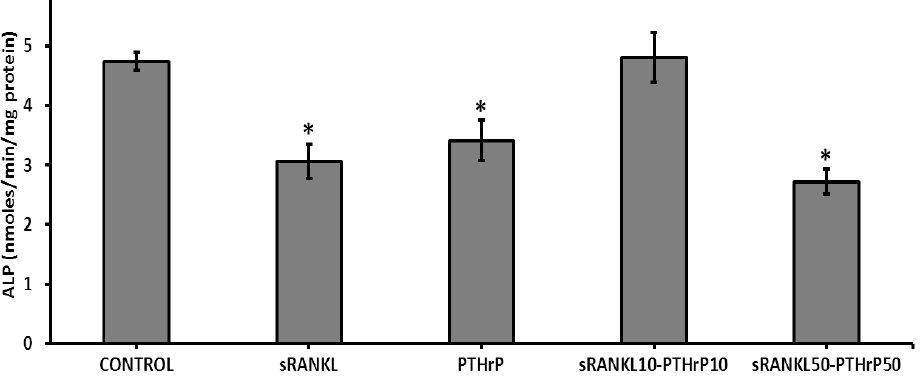
Figure 7. Cellular alkaline phosphatase (cALP) expression of differentiated MSCs by sRANKL and PTHrP, * p < 0.05 vs control.